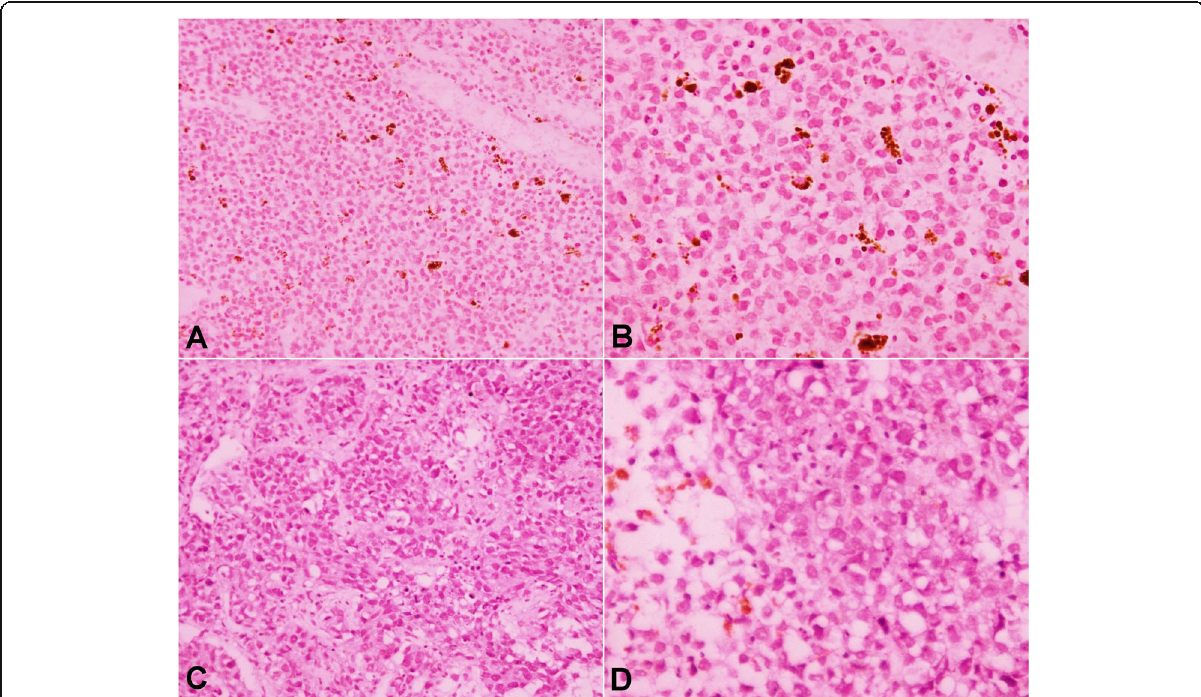
Fig. 2 Histopathological examination of urethral small cell melanoma with neuroendocrine differentiation: Biopsy from the urethral mass showed tumor cells arranged in a solid pattern ( a , H&E, ×200). The tumor cells had high nucleocytoplasmic ratio, moderately pleomorphic nuclei with conspicuous nucleoli at places, and melanin granules in the cytoplasm ( b , H&E, ×400). Biopsy from the liver lesion also showed a similar tumor. Frequent apoptoses and mitoses were seen (H&E; ×200, c ; and ×400, d )